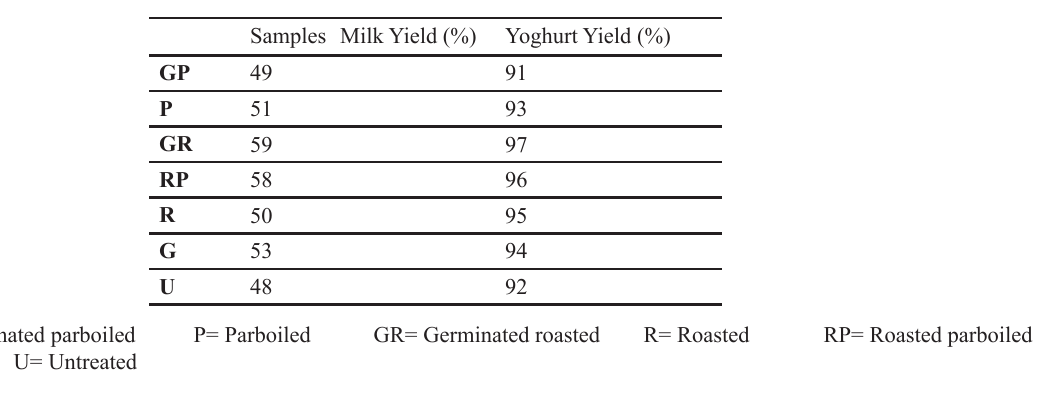
Table 1: Yield of milk and yoghurt from pre-treatment Bambara groundnut.